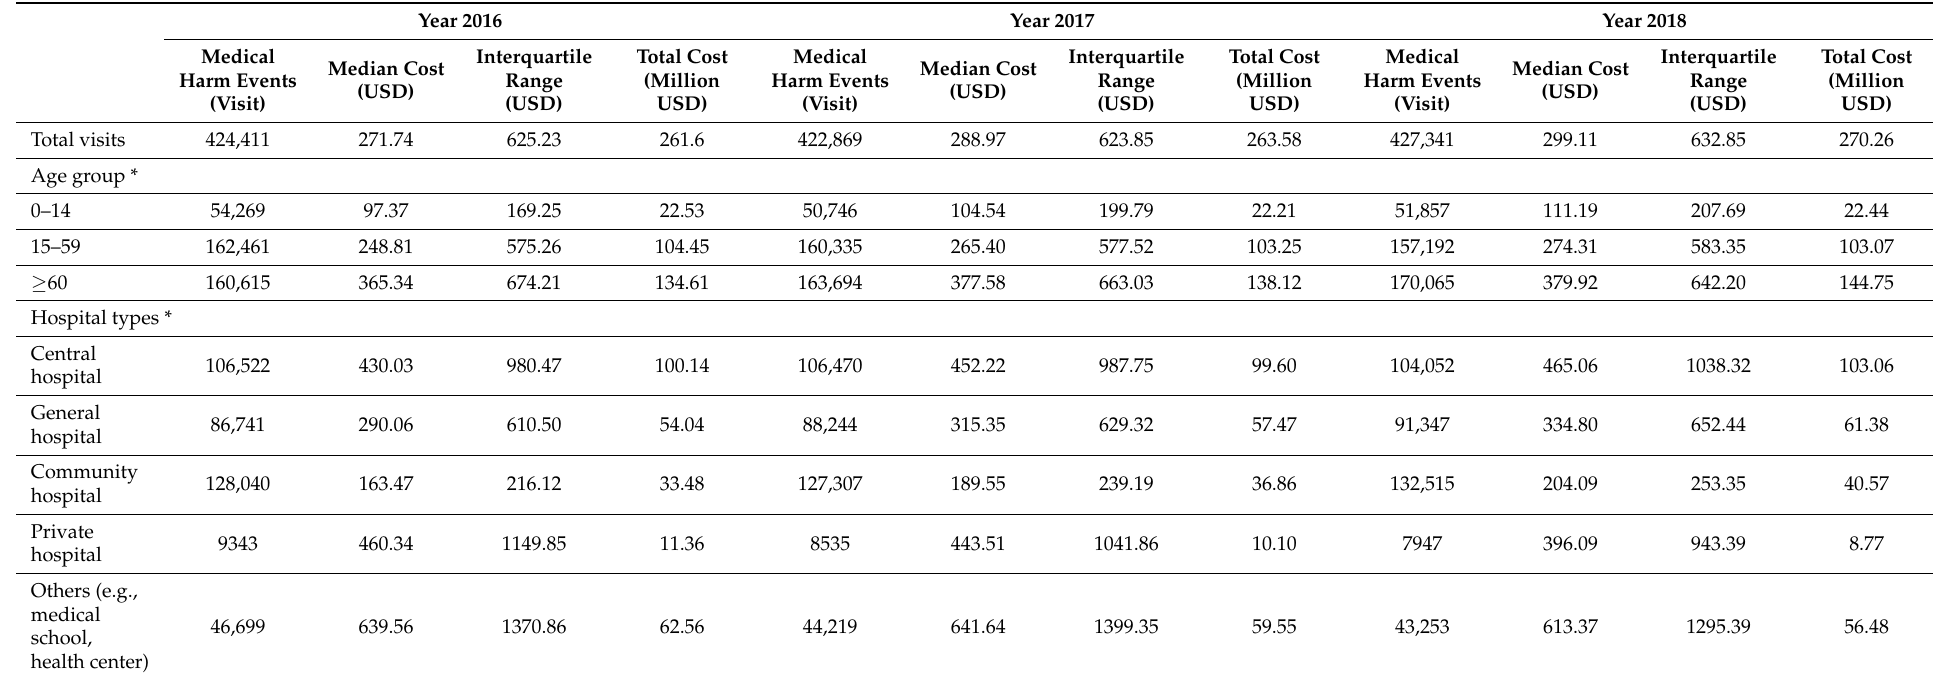
Table 3. Estimated cost burden of medical harm in each group between 2016 and